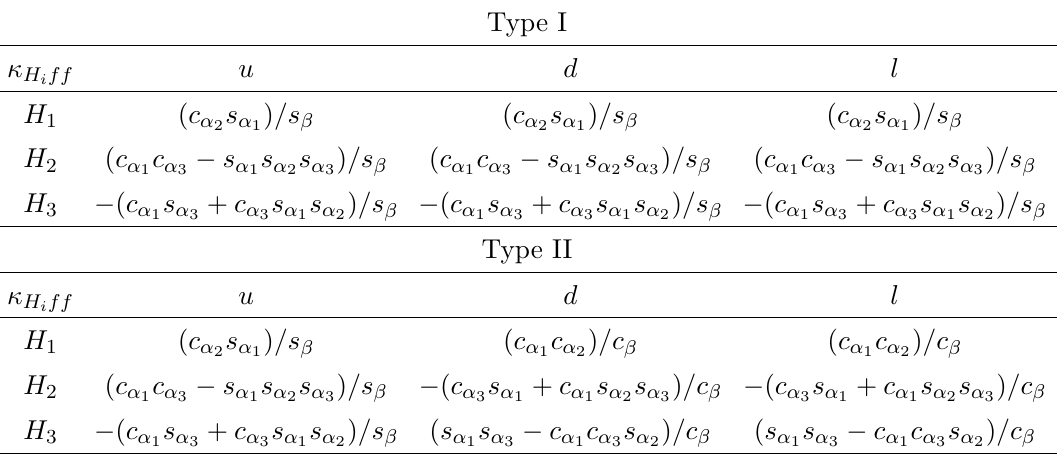
of the N2HDM Higgs bosons H i , as de(cid:12)ned in i ff